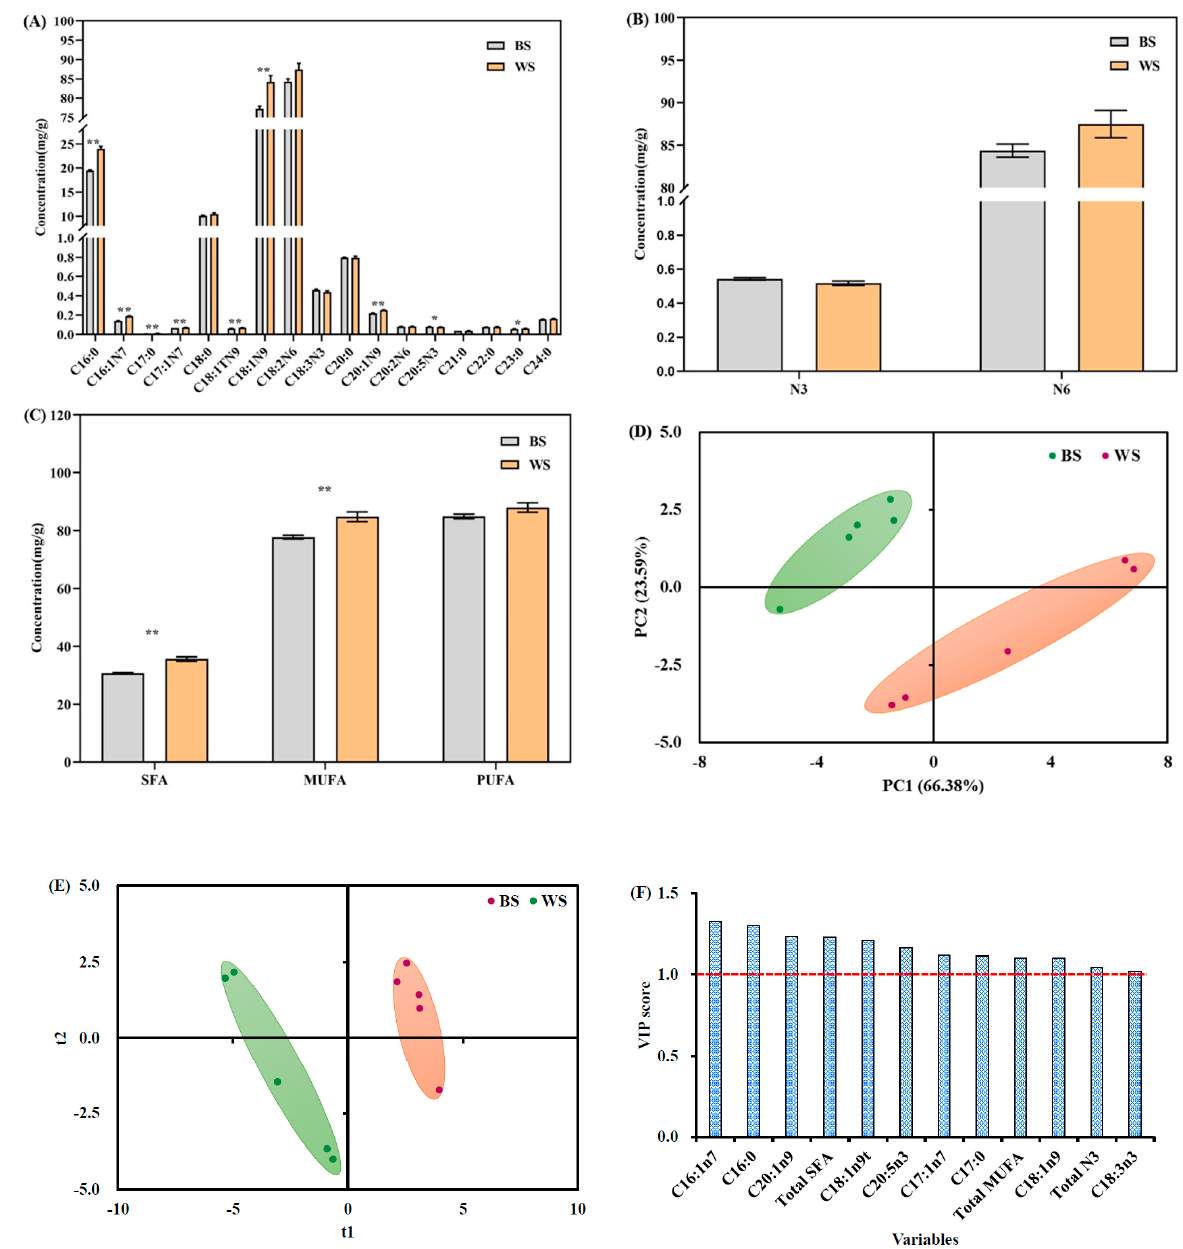
Figure 3. ( A ) Contents of individual FAMEs in the sesame seed samples. ( B ) Contents of n-3 and n-6 FAMEs in the sesame seed samples. ( C ) Contents of different subclasses of FAMEs in the sesame seed samples. ( D ) PCA score plot on the FAME data. ( E ) PLS-DA score plot on the FAME data (R 2 X = 0.90, R 2 Y = 0.99, and Q 2 = 0.97). (F) Bar chart of the VIP scores of the candidate FAME markers for the two groups of sesame seeds. The level of significance was defined as p value < 0.05 * and <0.01 **. BS, black sesame seeds; WS, white sesame seeds; FAME, fatty acid methyl ester; SFA, saturated fatty acids; MUFA, mono-unsaturated fatty acids; PUFA, poly-unsaturated fatty acids; VIP, variable importance in projection.